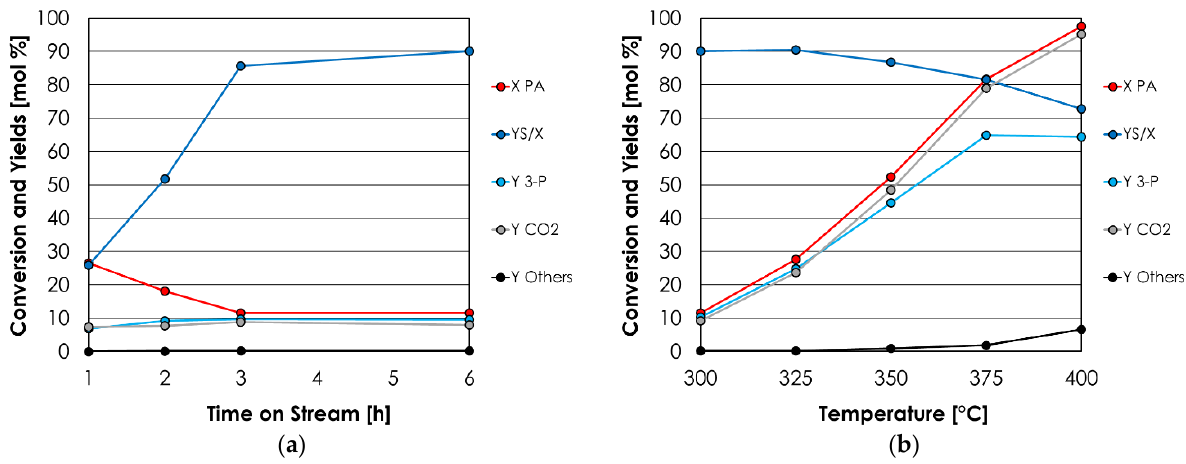
Figure 1. ( a ) Catalytic activity of Al/P/O for the ketonization of PA to 3-P as a function of the time on stream. Reaction conditions: temperature = 300 °C, PA = 6 mol % in N 2 , time factor = W/F = 0.8 s·g/mL. ( b ) Catalytic activity of Al/P/O for the ketonization of PA to 3-P as a function of reaction temperature. Reaction conditions: temperature = variable, PA = 6 mol % in N 2 , time factor = W/F = 0.8 s·g/mL. Symbols: propionic acid conversion (X PA, red), sum of yields (YS, blue), 3-pentanone yield (Y 3-P, light blue); CO 2 yield (Y CO 2 , gray); by-products sum of yields (Y others, black).